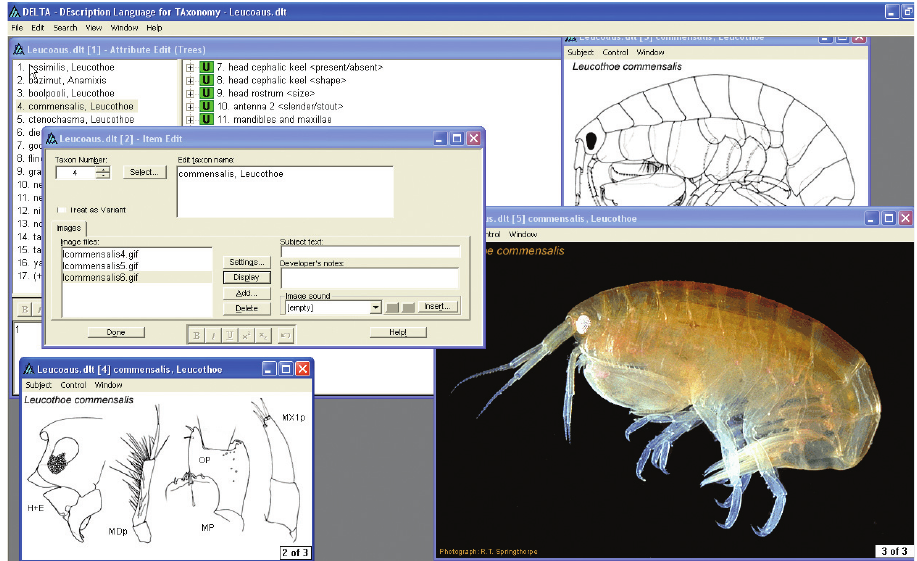
Figure 16. Selection of taxon illustrations from the Taxon